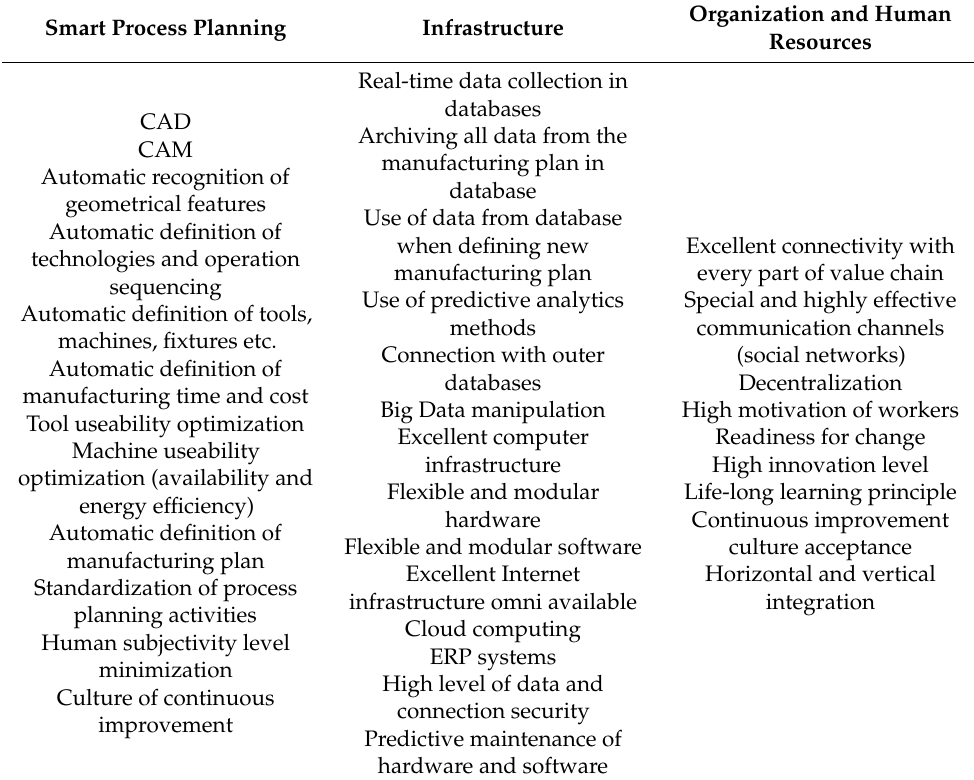
Table 3. Criteria for process planning-oriented readiness factor